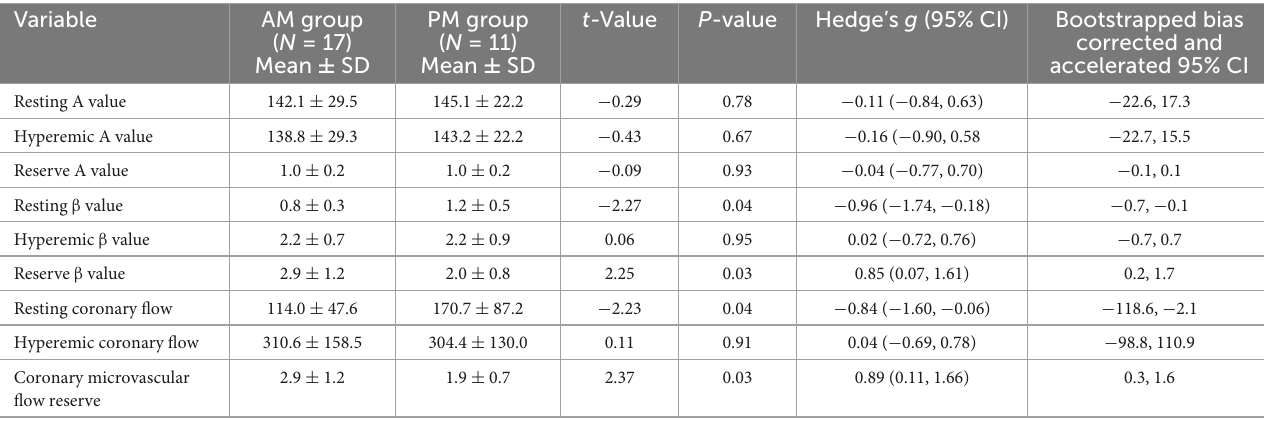
TABLE 2 Parametric data